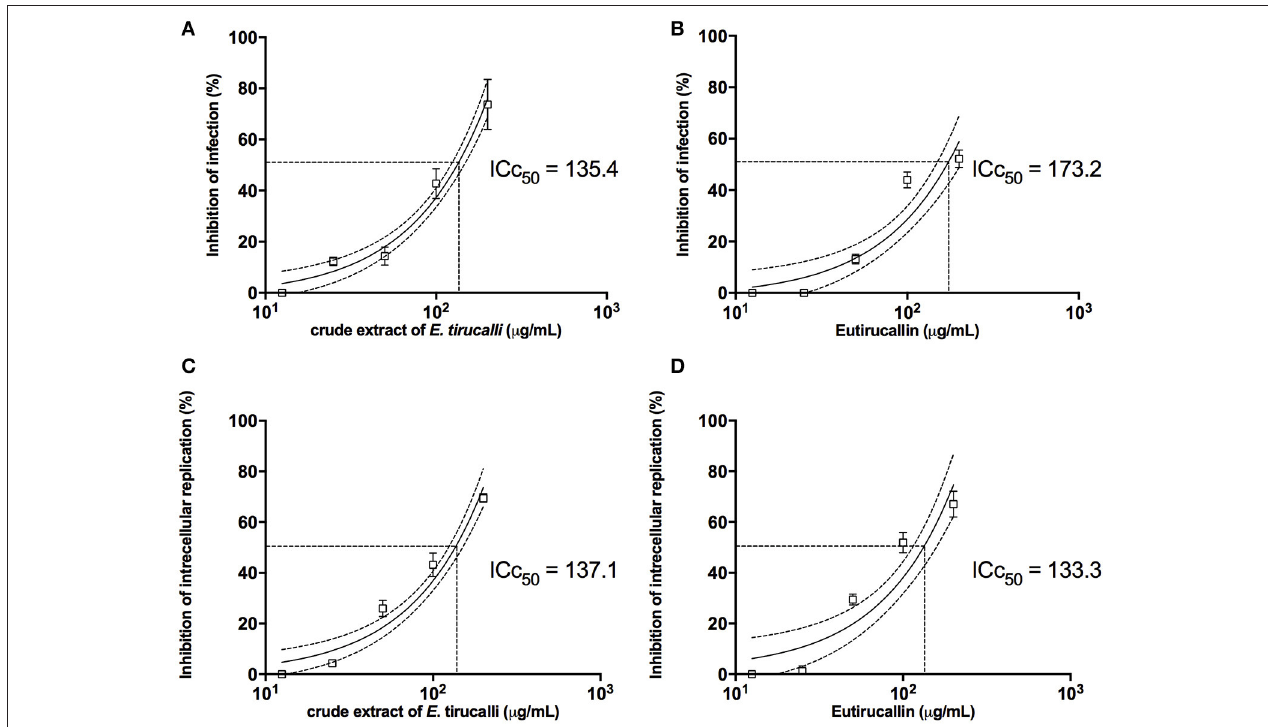
FIGURE 8 | The E. tirucalli effects on T. gondii infection. (A,B) Inhibition of T. gondii infection when treatment with E. tirucalli crude extract and Eutirucallin and (C,D) inhibition of T. gondii intracellular replication after treatment with E. tirucalli crude extract and Eutirucallin. Results are expressed as mean and SD of the percentages of infection inhibition and intracellular replication related to controls. Dotted lines show the inhibitory concentration of 50% (IC 50 ).